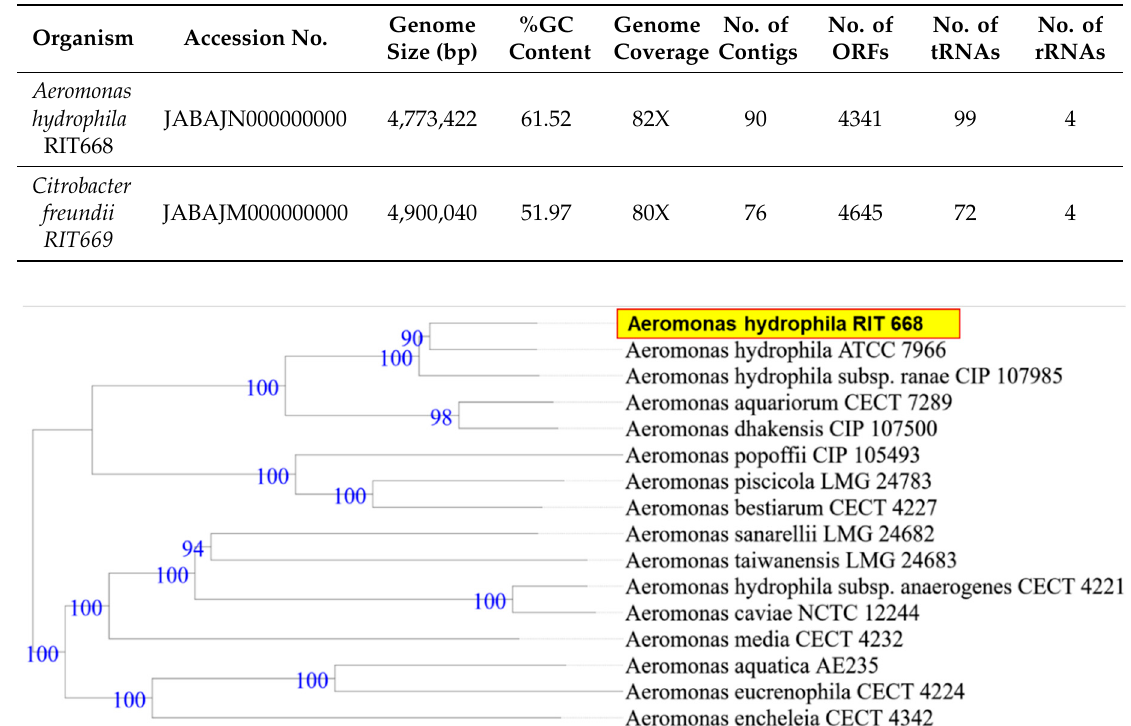
Figure 1. WGS-based phylogenetic tree for A. hydrophila RIT668, using the TYGS platform. TYGS infers trees with FastME 2.1.4 [103] based on Genome BLAST Distance Phylogeny (GBDP) distances calculated from the genome sequences. Branch lengths are scaled in terms of GBDP distance formula d5 [107]. Numbers above branches are GBDP pseudo-bootstrap support values from 100 replications.